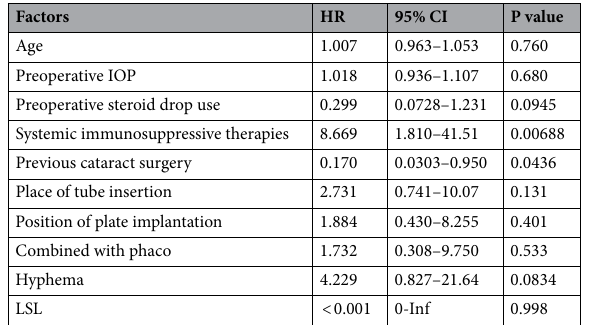
Table 4. Cox proportional hazard analysis for qualified criterion A for surgical failure. HR, hazard ratio; CI, confidence interval; IOP, intraocular pressure; LSL, laser suturelysis.